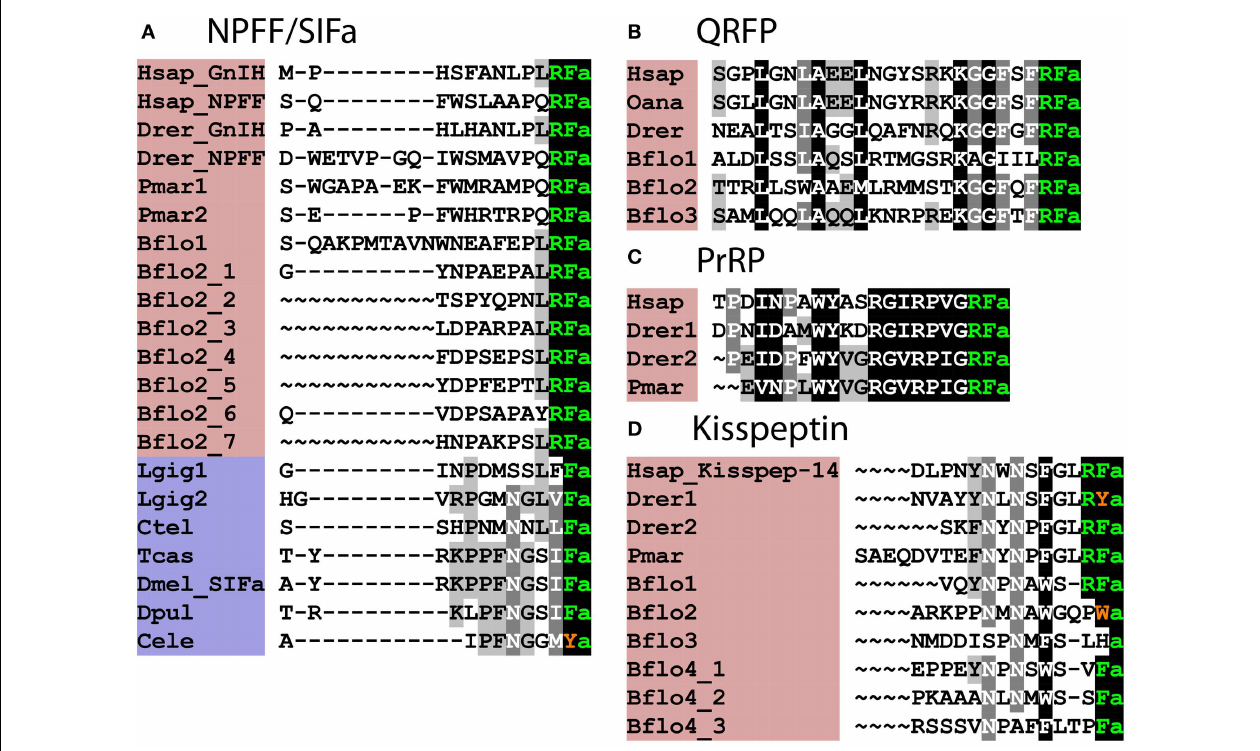
FIGURE 2 |Alignment of known orthologous peptides from (A) bilaterian NPFF/SIFa (B), chordate QRFP, (C) vertebrate PrRP, and (D) chordate kisspeptin families .The names of deuterostomian and protostomian peptides are shaded in pink and blue, respectively.The C-terminal amide groups are represented by an “a” at the end of aligned sequences.The lamprey sequences are from Ref. (26), other vertebrate and B. floridae sequences are from Ref. (8), the Lottia gigantea sequences are from Ref. (4), and the Capitella teleta sequence is from Ref. (5). For vertebrate sequences, only one peptide from each precursor is shown in the alignment. Genbank (GI) or JGI IDs of all precursor sequences are listed below: (A) alignment of chordate NPFF/SIFa peptides: Hsap_GnIH, Homo sapiens GnIH (GI:11125707); Hsap_NPFF, Homo sapiens NPFF